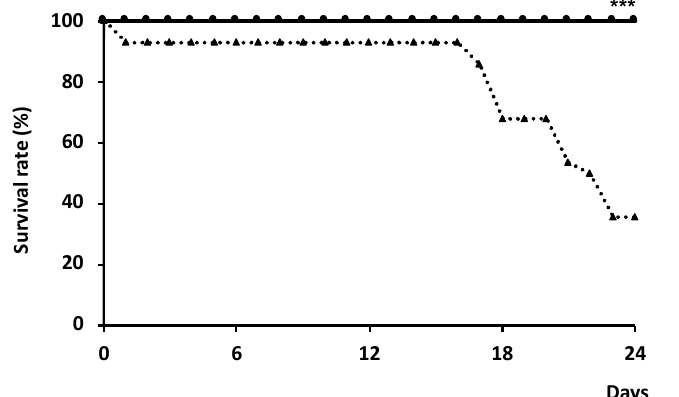
Figure 3. Survival curves for severely infected yellowtail with parasites. Solid and dotted lines indicate silkrose-treated and control group, respectively. Asterisks indicate statistically significant differences compared with control group by log rank test with Bonferroni correction (*** p < 0.001).